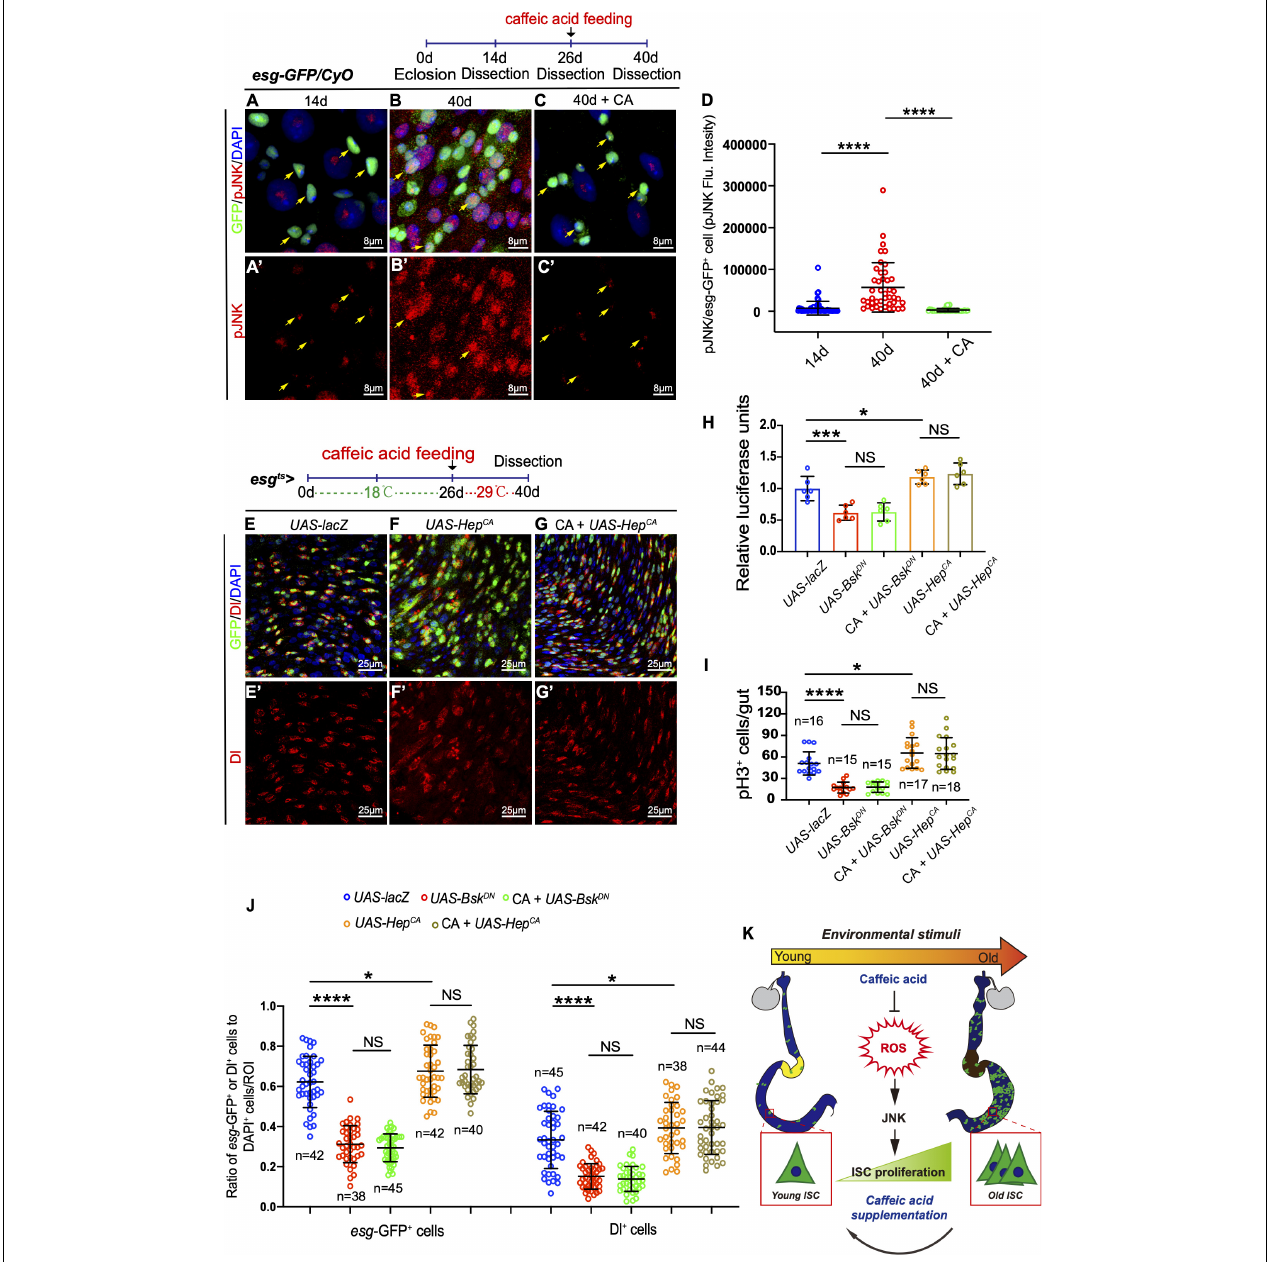
FIGURE 6 | CA prevents ISC aging by counteracting oxidative stress-associated JNK activity. (A–C) Representative immunofluorescence images of the R4 region of dissected midguts of 14-, 40-, and 40-day flies treated with CA. Arrows indicate esg -positive cells. esg -GFP (green; ISC and EB markers) and pJNK (red; an indicator of JNK signaling activation). Panels (A–C) represent merged images and panels (A’–C’) are for pJNK (red) only. (D) Quantitation of the pJNK intensity in esg -positive cells from 14-, 40-, and 40-day flies treated with CA. Each dot corresponds to one cell. (E–G) Immunofluorescence images of the R4 region of dissected midguts of aged flies with indicated genotypes and treatment. esg -GFP (green; ISC, and EB markers) and Dl (red; ISC marker). Panels (E–G) represent merged images and panels (E’–G’) are for Dl (red) only. (H) Quantification of the luciferase activity of Drosophila midguts with indicated genotypes and treatment. Error bars represent the SD of six independent experiments. (I) Quantification of the numbers of pH3 + cells of flies with indicated genotypes and treatment. N (from left to right) = 16, 15, 15, 17, and 18. (J) Quantification of the number of esg -GFP + cells, Dl + cells of flies with indicated genotypes and treatment. N (from left to right) = 42, 38, 45, 42, 40, 45, 42, 40, 38, and 44. (K) Schematic model of the mechanism by which CA restrains Drosophila intestinal stem cell aging. Caffeic acid promotes oxidation resistance, which attenuates oxidative stress, prevents the over-activation of JNK signaling, and inhibits the hyperproliferation of ISCs, thus extending the lifespan and healthspan of Drosophila . DAPI stained nuclei are shown in blue in panels (A–C,E–G) . Scale bars represent 8 µ m in panels (A–C) . Scale bars represent 25 µ m in panels (E–G) . Error bars represent SDs. One-way ANOVA test, * P < 0.05, *** P < 0.001, **** P < 0.0001, and non-significant (NS) represents P > 0.05.